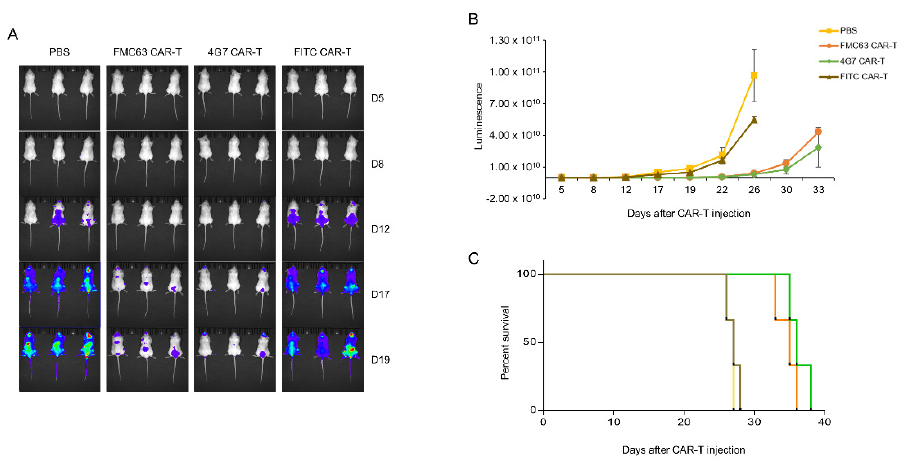
Figure 5. In vivo, both FMC63 and 4G7 CAR T cells eliminated acute-lymphoblastic-leukemia-cell NALM-6. ( A – C ) NOD.Cg-PrkdcscidIl2rgtm1Wjl / SzJ (NSG) mice were injected intravenously (i.v.) with 5 × 10 6 Luc-expressing NALM-6 cells. Next day, mice were administered with 1 × 10 7 FMC63, 4G7, and FITC CAR T cells or phosphate buffered saline (PBS) control (i.v.). From day 5, tumor progression was observed via bioluminescence imaging. ( A ) Represents the luminescence image, and ( B ) indicates the luminescence value of each group. ( C ) Percentage survival was calculated.